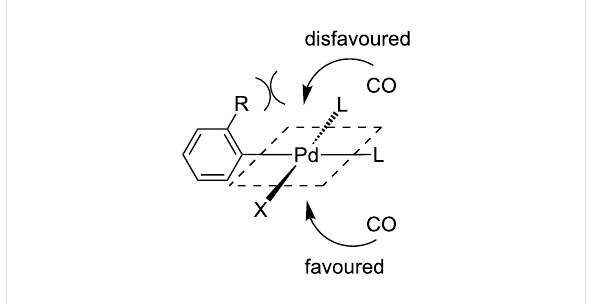
Figure 1: Steric interactions of the carbon monoxide coordination to the aryl complex intermediate.